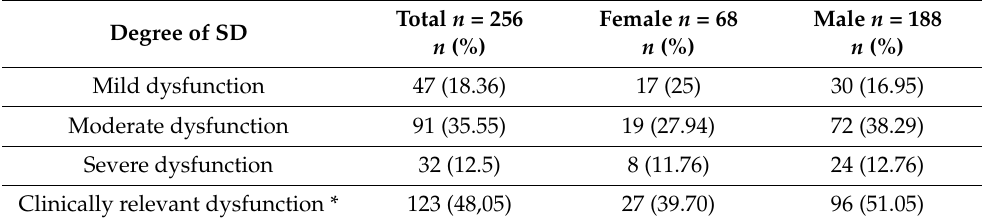
Table 1. Degree of Sexual Dysfunction in the sample: SALSEX questionnaire scores.